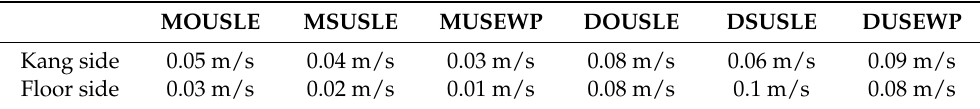
Table 9. The average air velocity on the kang side and the floor side when the ventilation volume is Q = 29 m 3